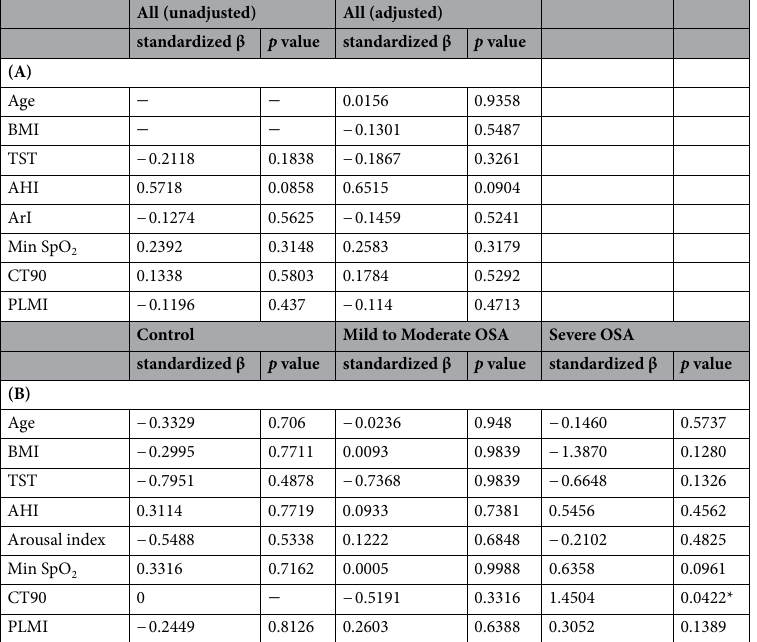
All (unadjusted) All